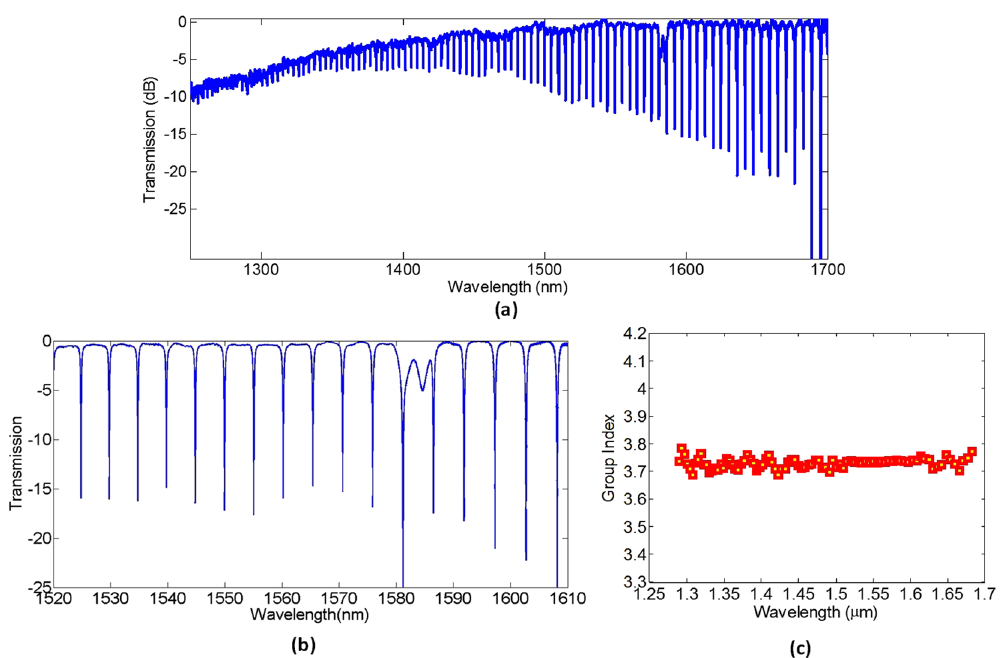
Figure 7. Transmission spectrum at 1550 nm for a ring resonator with R = 20 µ m and G = 150 nm for the quasi – TE mode of 300 nm × 600 nm waveguide measured using ( a ) a supercontinuum source and ( b ) an amplified spontaneous emission source. ( c ) The measured group index as a function of wavelength extracted from ( a